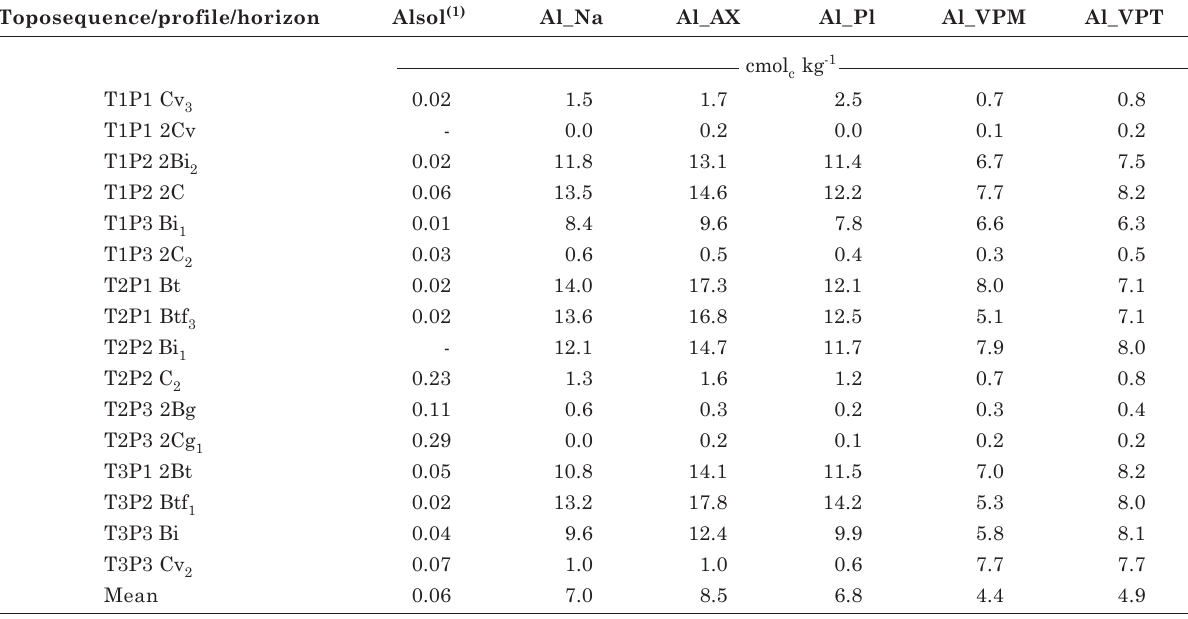
Table 5. Aluminium contents of the horizons determined by different